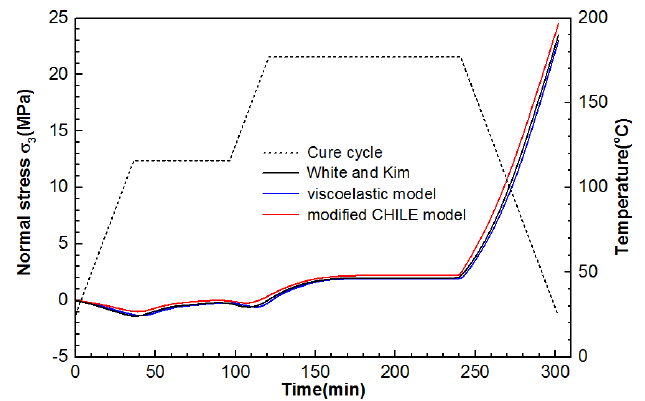
 development at the point (5.08, 0, 1.27) of the composite Figure 10. Interlaminar normal stress σ 3 development at the point (5.08, 0, 1.27) of the Figure 10. Interlaminar normal stress 3 composite laminate under manufacture recommended cure cycle from the modified CHILE and laminate under manufacture recommended cure cycle from the modified CHILE and viscoelastic Materials 2019 , 12 , x FOR PEER REVIEW viscoelastic models. models. Materials 2019 , 12 , x FOR PEER REVIEW